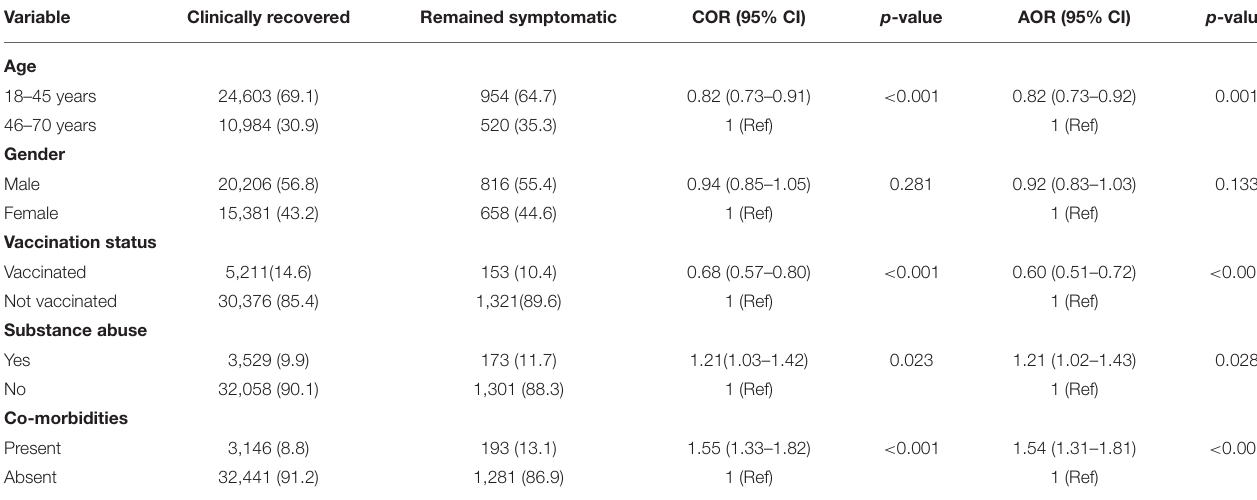
TABLE 3 | Association between demographic and clinical variables with clinical